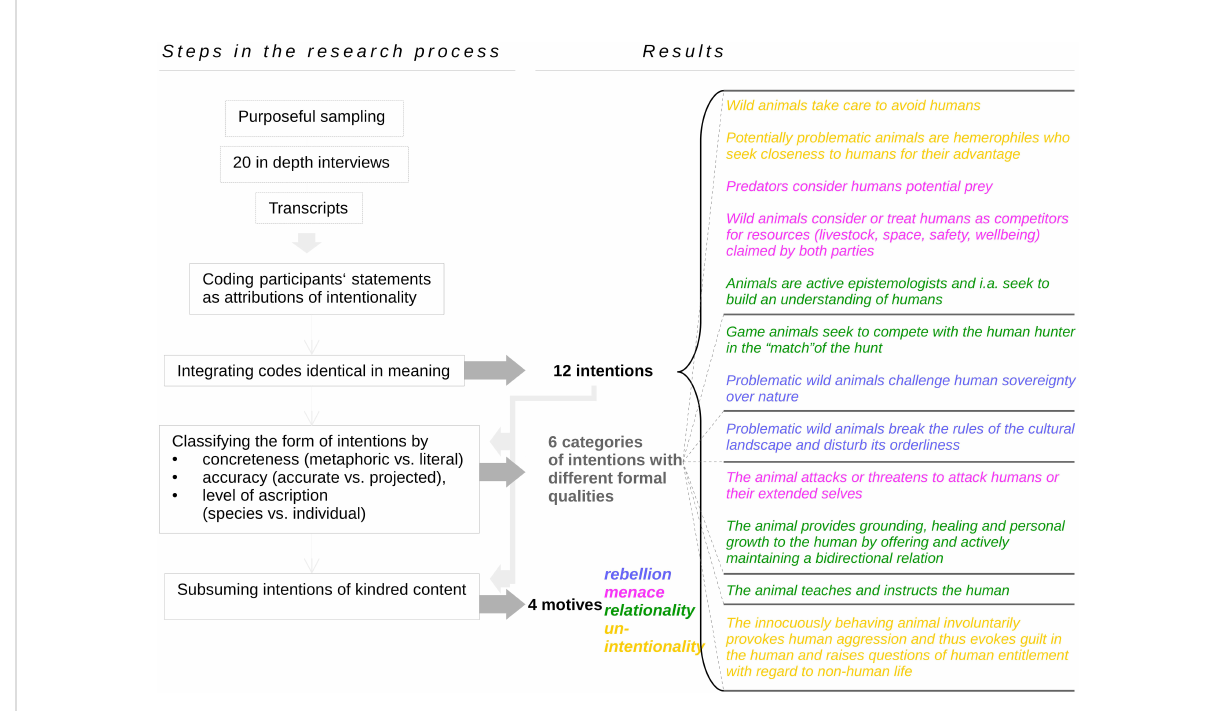
FIGURE 1 Graphical abstract of the individual steps in the research process and the results they